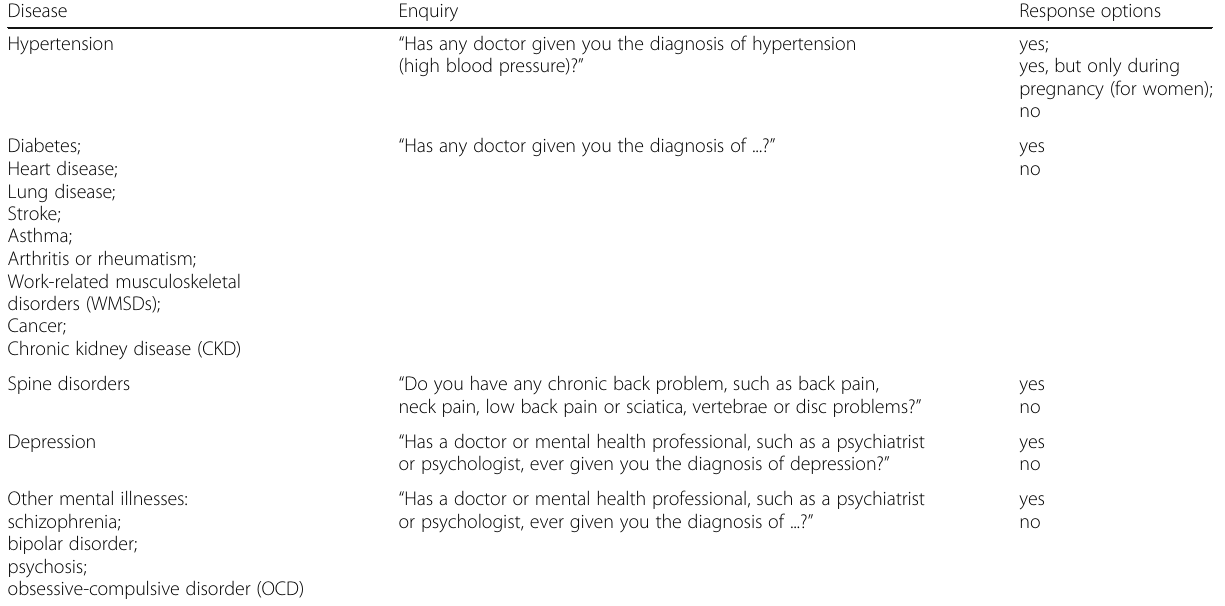
Table 1 Enquiry into non-communicable diseases in the National Health Survey (PNS) Disease Enquiry Response